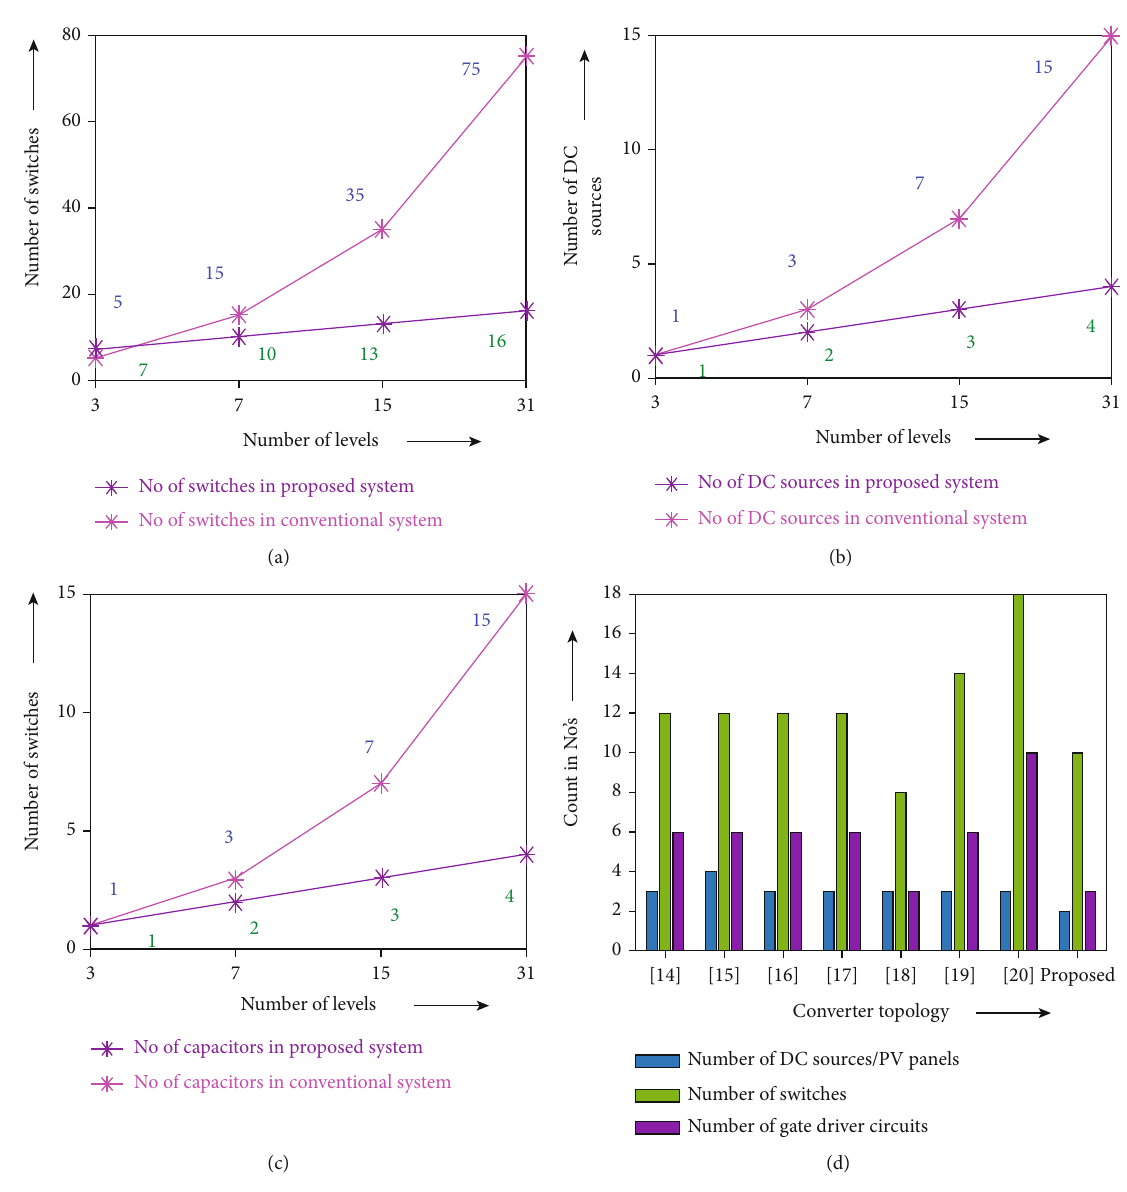
Figure 14: Comparative analysis of controlled switches. (b) Comparative analysis of DC sources. (c) Comparative analysis of capacitors. (d) Comparative analysis with di ff erent seven-level hybrid converter